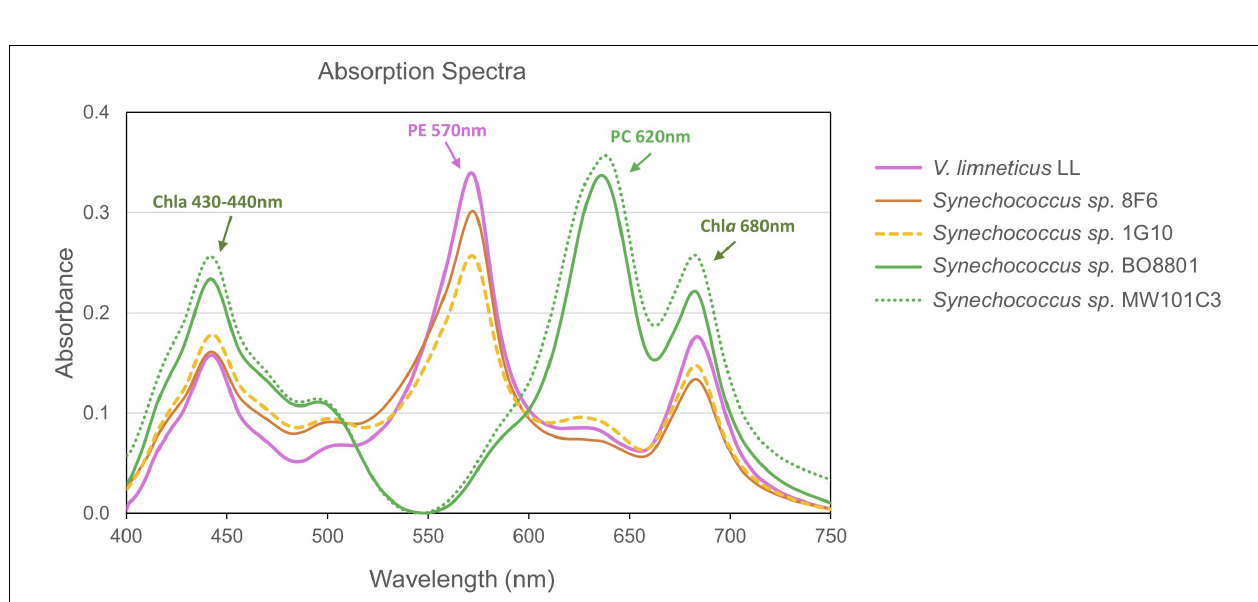
FIGURE 6 | Diversity of pigment absorbance spectra of the five non-marine Synechococcus strains studied.